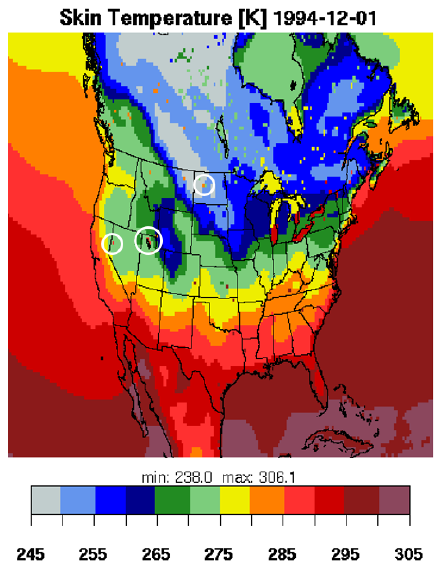
Figure 2. The skin temperature (K) processed from CESM to the 36km WRF grid using WPS and valid at 00:00UTC, 1 Decem- ber 1994. White circles indicate the locations of Pyramid Lake, Great Salt Lake, and Lake Sakakawea, from west to east, respec-